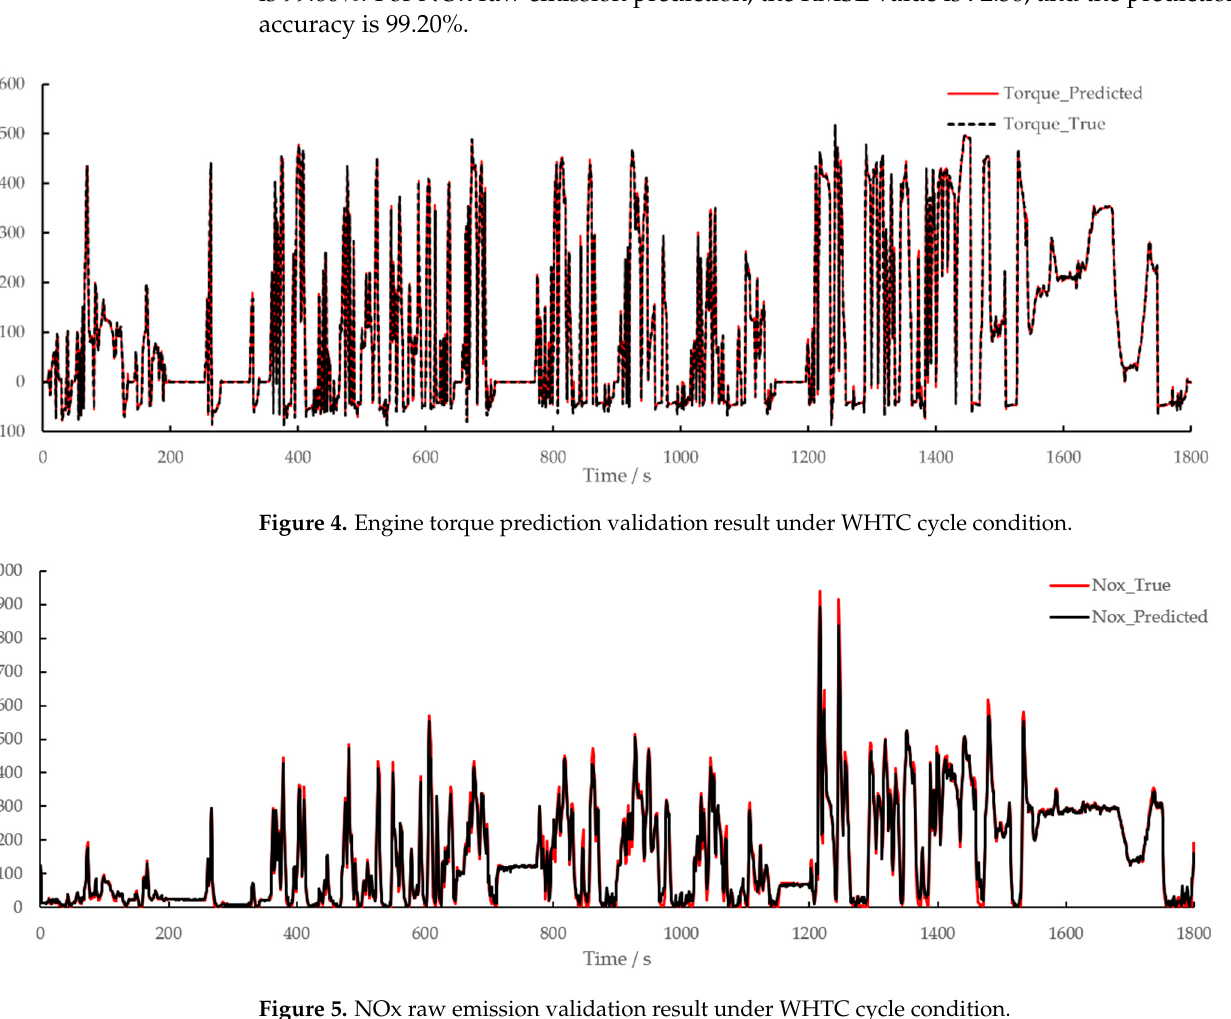
Figure 5. NOx raw emission validation result under WHTC cycle condition.